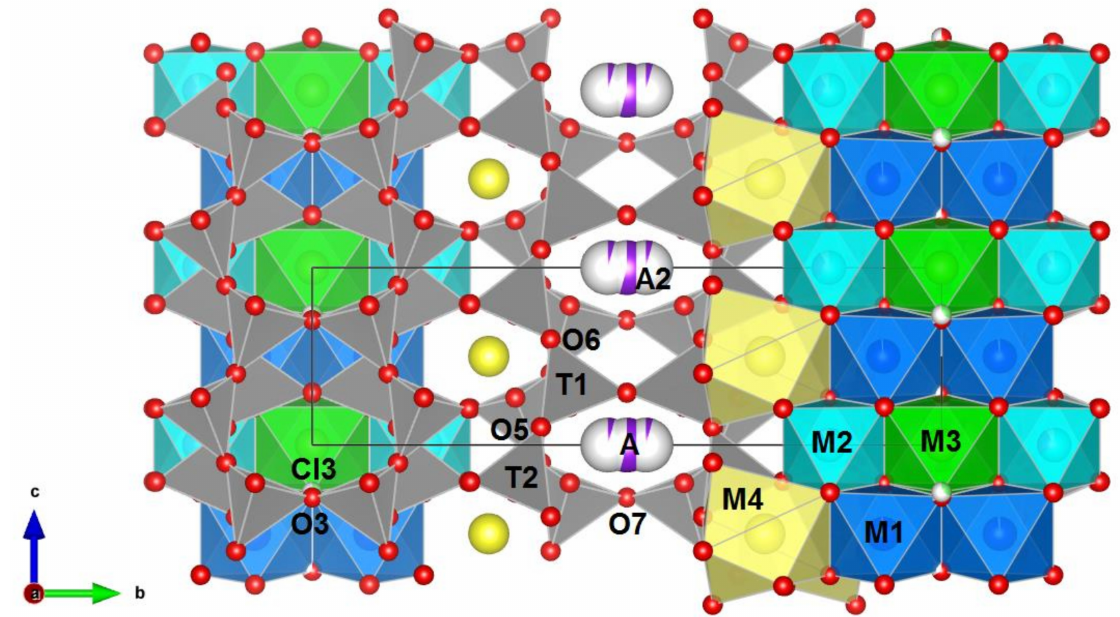
Figure 4. Crystal structure of potassic-hastingsite projected along the a axis. Oxygen atoms are drawn in red. Si-tetrahedra and mixed Si-Al tetrahedra are gray. M 1—blue, M 2—cyan, M 3—green octahedra, M 4—yellow polyhedra. A and A2 positions are designated as lilac spheres. Cl3 sites are drawn in light green. The partially white coloring of the spheres indicates a vacancy. The relations between the ribbon of octahedra and the double-chain tetrahedra are shown.